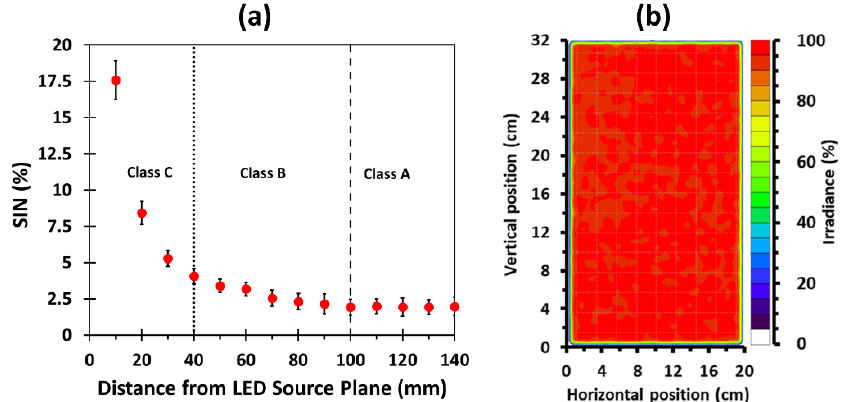
Figure 6. ( a ) Plotted SNI against test plane distance. Error bars are calculated from the standard deviation of simulation results. ( b ) The modeled irradiance map of 532 LED emissions from 10 LED colors mounted in a housing with internal mirrors. The color scale bar shows the irradiance between 0% and 100% of the maximum irradiance.